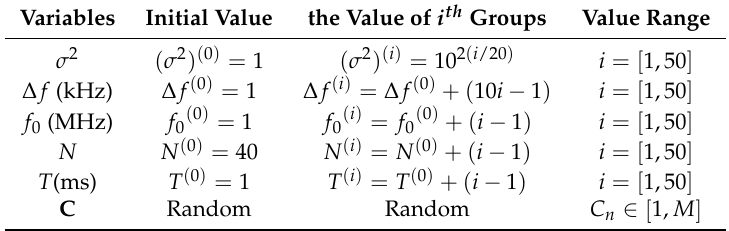
Table 1. Parameters setting for multiple groups of SSF